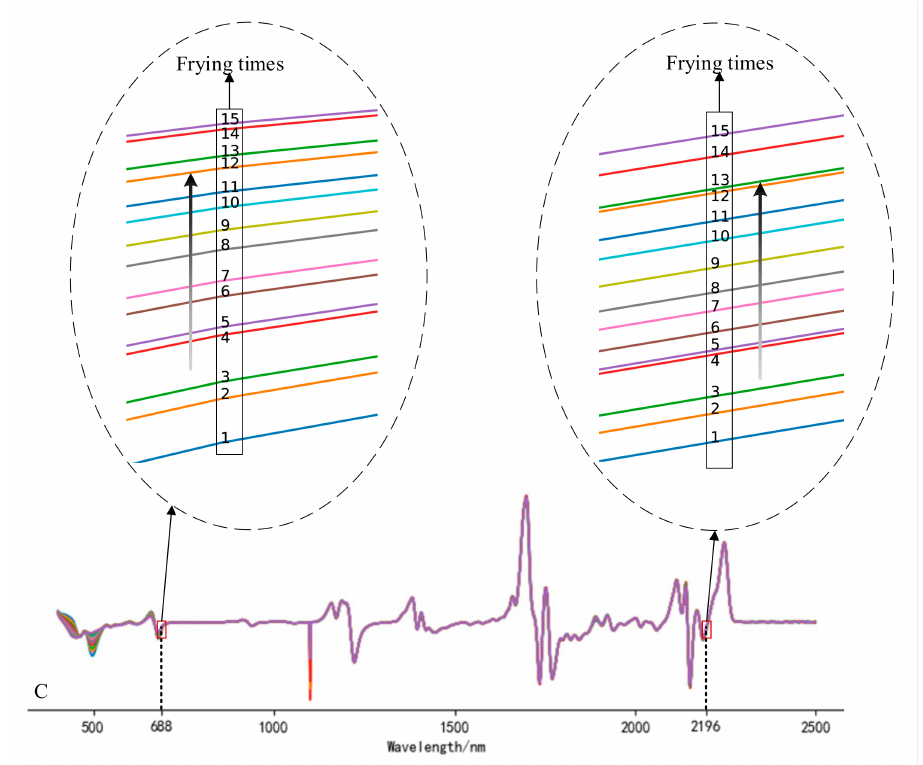
Figure 2. Spectrogram of soybean oil ( A ), peanut oil ( B ), rapeseed oil, ( C ) after first derivative (1D) treatment.